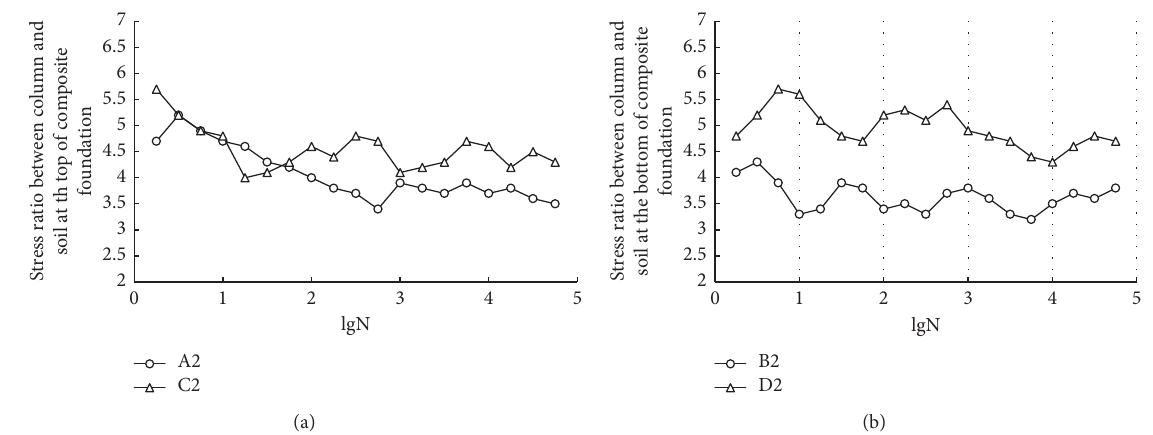
Figure 12: Stress ratio between the stone column and soil: (a) CLR � 0.2 and CLR � 0.4; (b) CLR � 0.3 and CLR � 0.5.